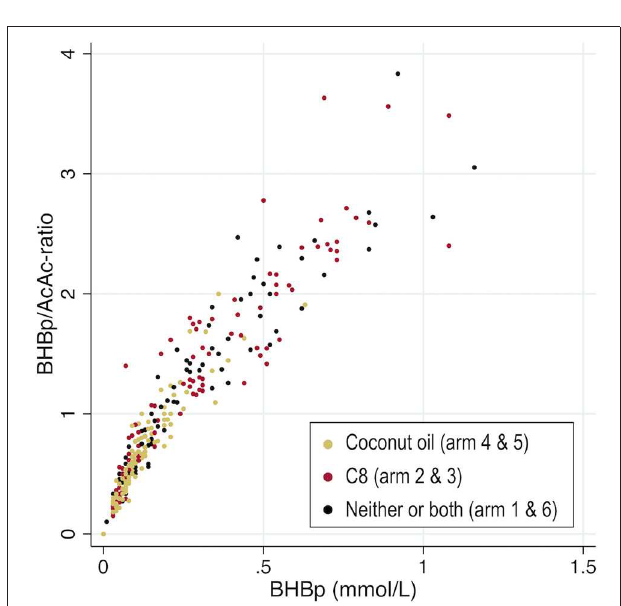
FIGURE 6 | Distribution of blood glucose levels in the four arms with a 16-h non-carbohydrate window. T0 represents time for start of ingestion of fatty acids, preceded by 12h fasting. (5 mmol/L = 90 mg/dL).